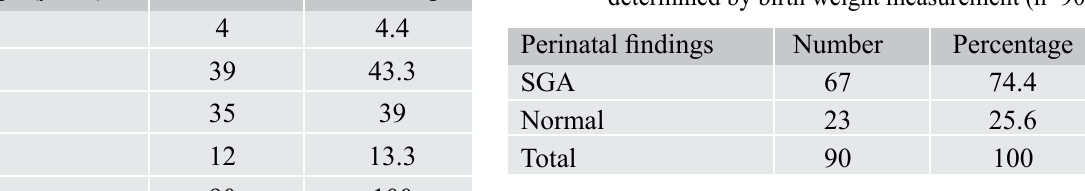
Table I: Age distribution of patients (n=90) Age groups (years)